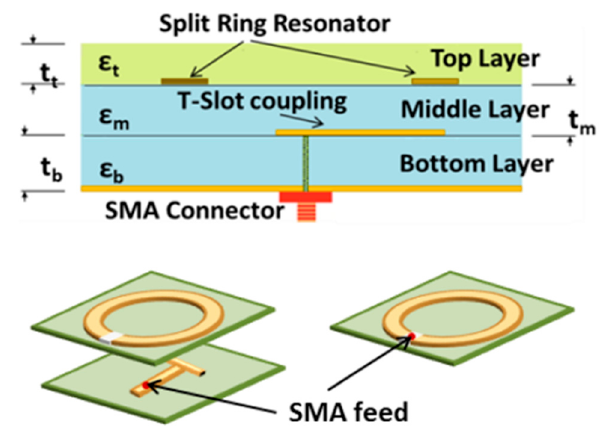
Figure 3. Illustration of the internal structure of the SRR [31].